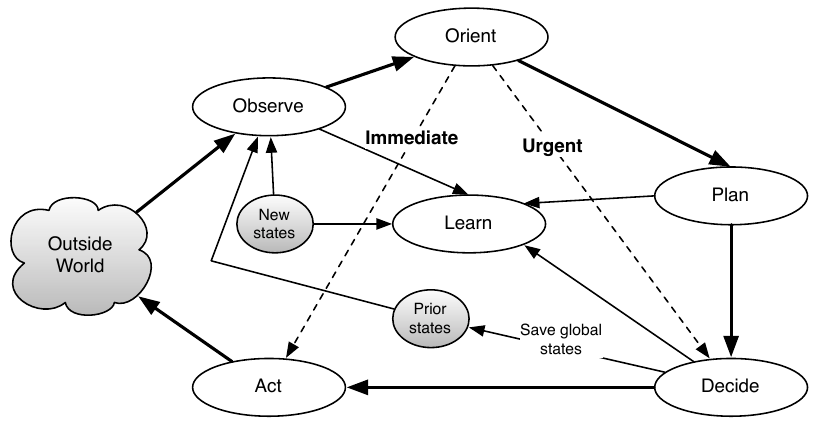
Figure 3. The extended OODA loop.